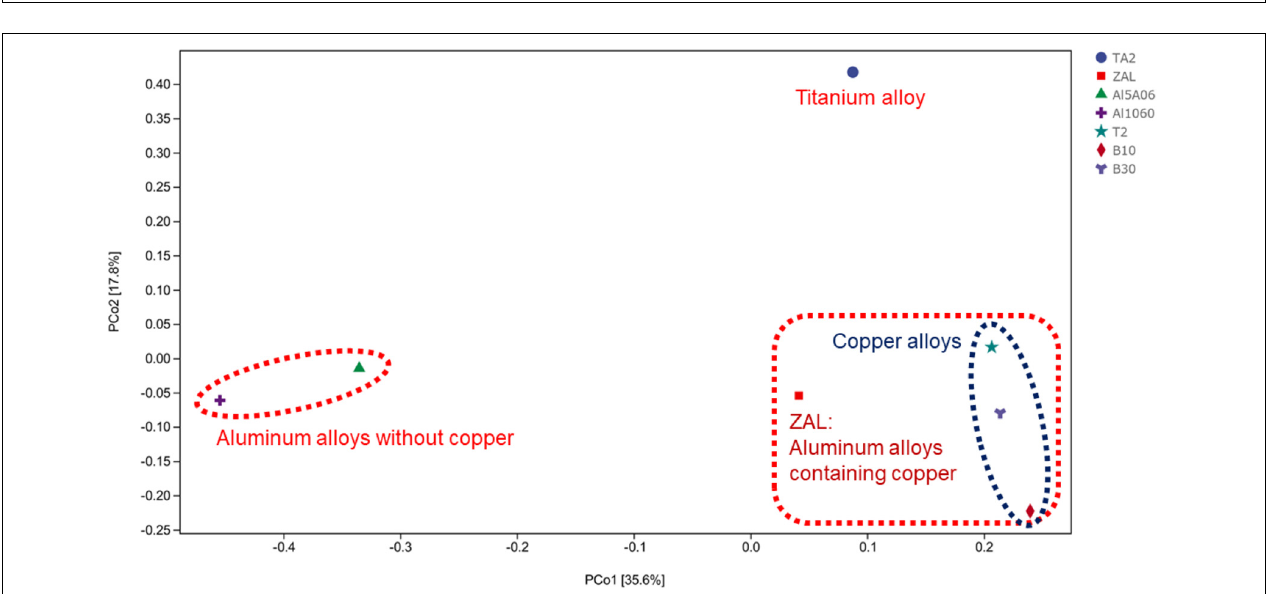
FIGURE 3 | Hierarchical cluster tree of seven samples in Yap Trench using the average pair-group method based on the unweighted unifrac distance for bacteria (TA2, ZAL, Al5A06, Al1060, T2, B10, and B30 represented the biofilms collected from the corresponding alloy surfaces. A1 group referred to the titanium sample TA2; A2 group referred to the aluminum alloy samples ZAL, Al5A06, and Al1060; and A3 group referred to the copper alloy samples T2, B10, and B30. The panel on the left was a hierarchical clustering tree with the abscissa representing the unweighted unifrac distance. Samples were clustered according to their similarity. The panel on the right was a stacked histogram of the top 10 genera in abundance).